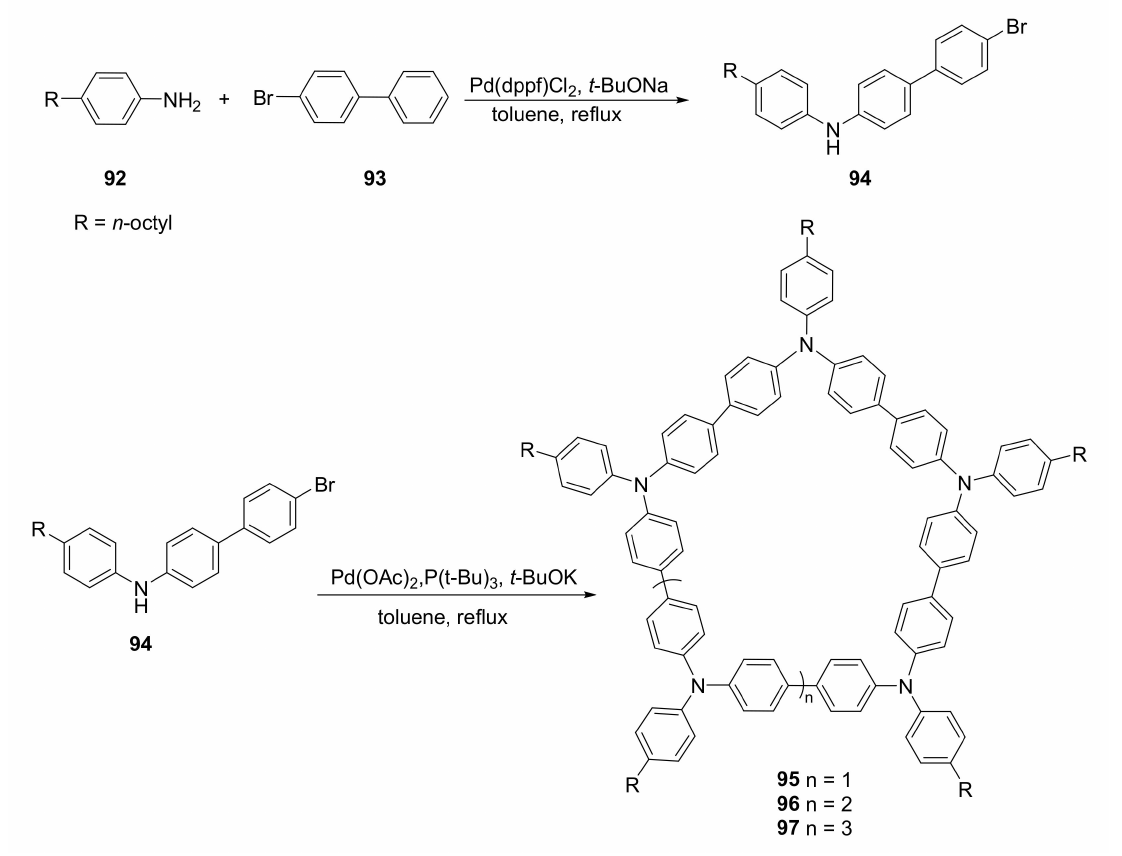
Figure 18. Synthesis of polyamine macrocycles 95 – 97 for selective fullerene recognition.